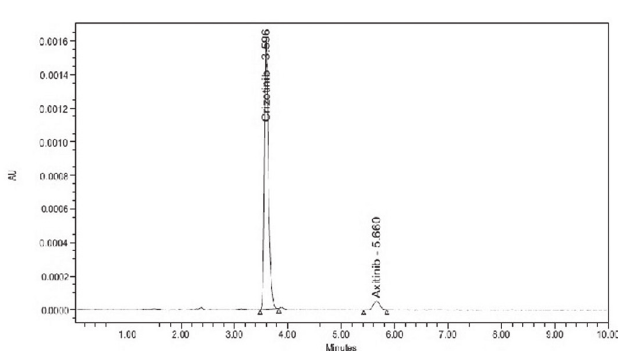
FIGURE 3 - Chromatogram of